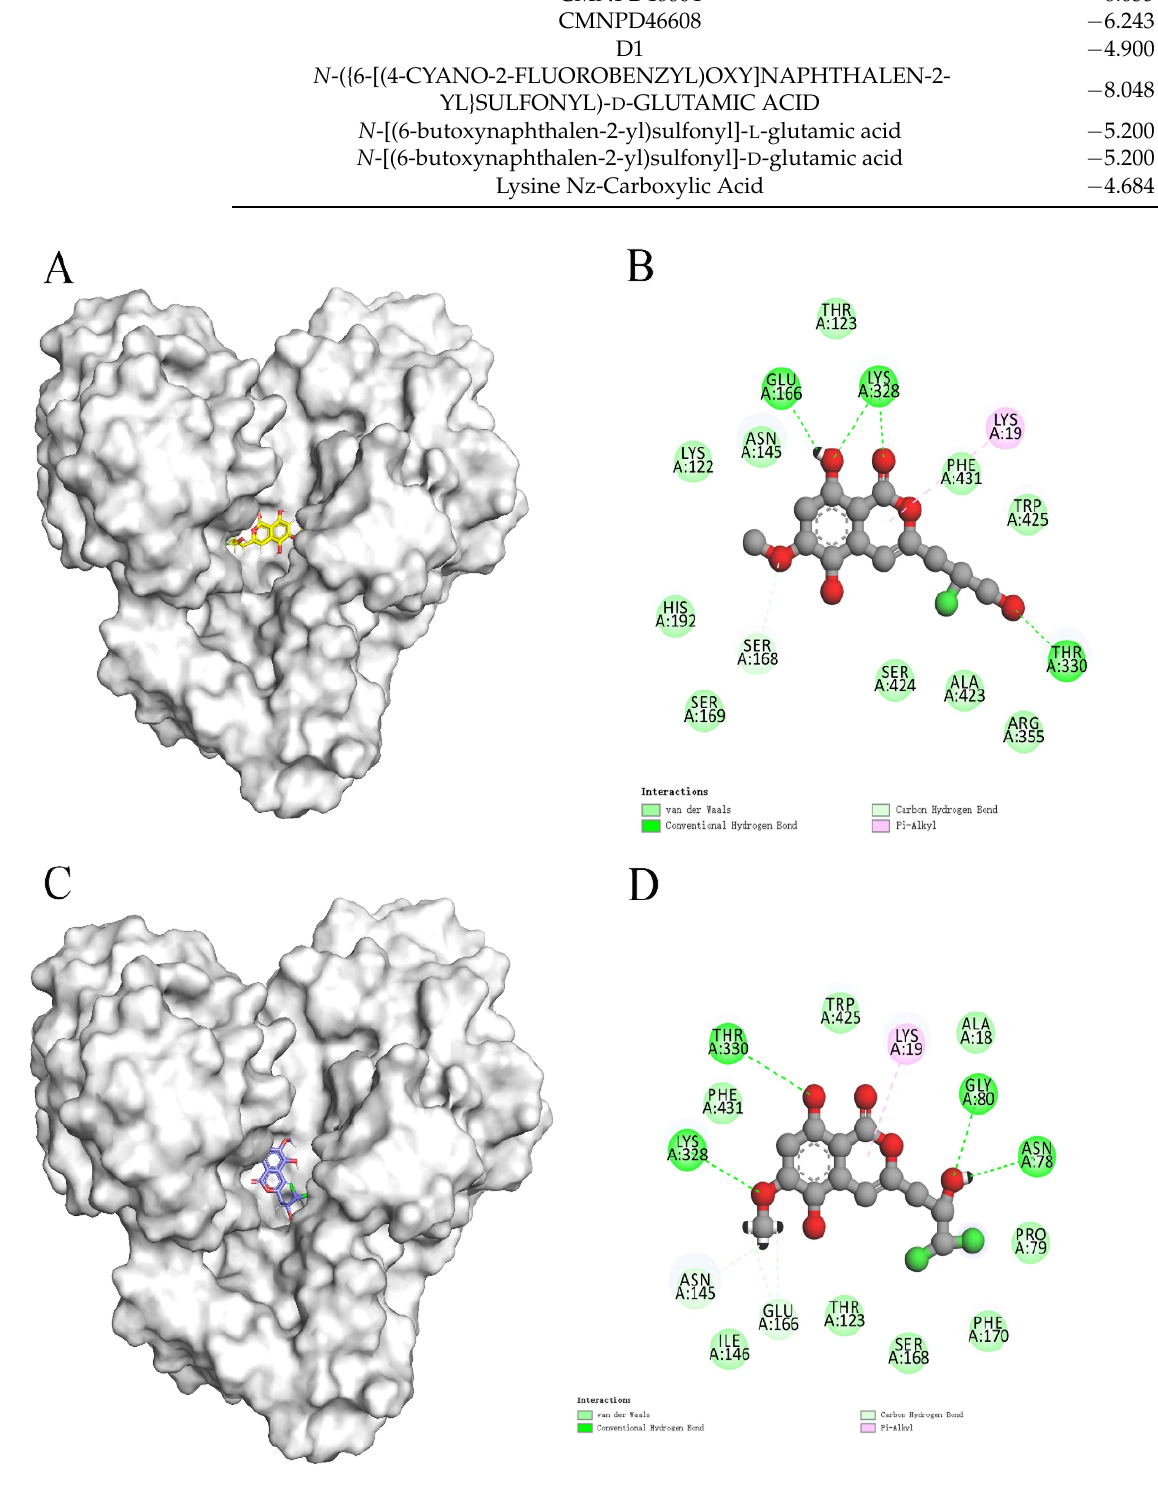
Figure 9. Two-dimensional interaction of 46604 and 46608 with MurD enzyme proteins. ( A ) 46604 (yellow) in the MurD Ligase binding bag. ( B ) 2D display of 46604 interaction in the MurD Ligase binding bag. ( C ) 46608(purple) in the MurD Ligase binding bag. ( D ) 2D display of 46608 interaction in the MurD Ligase binding bag. Table 4. MM-GBSA binding energy of the first 20 compounds with similarity.